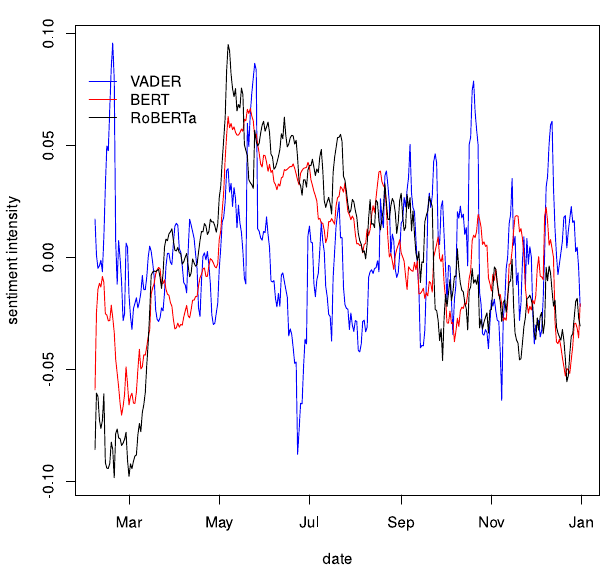
Figure 7. Year–Long time series of daily averaged compound sentiment polarity of COVID-19-related tweets, detrended, in Mexico . Each line represents a time series based on the same dataset collected [6] and restricted to Mexico, from 2 February to 31 December 2020. Data were smoothed via a 7-day rolling mean.